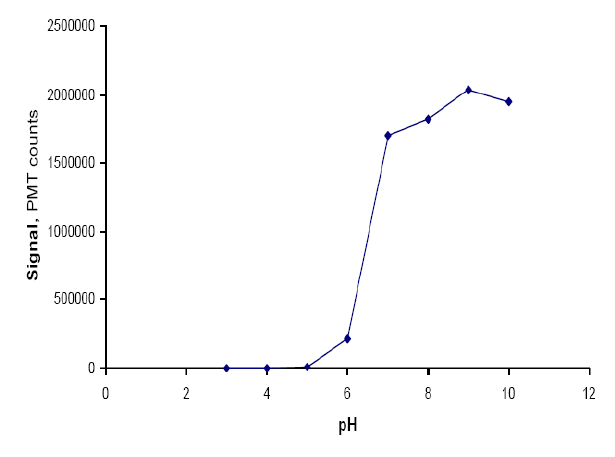
Figure 7. Signal resulting from a V. fischeri culture injected in carrier solutions of different